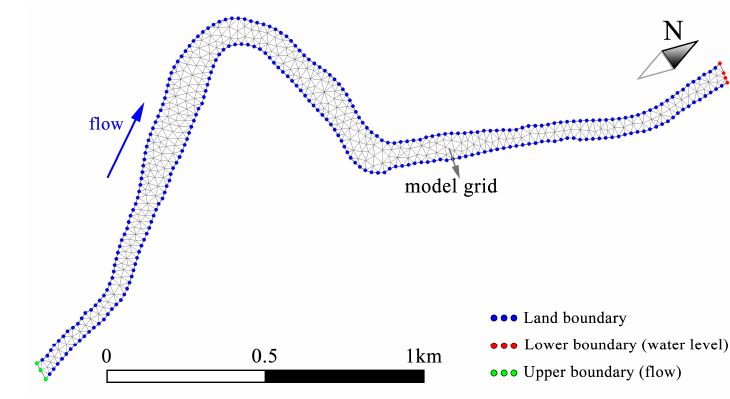
Figure 5. Habitat grid model. Water 2019 , 11 , x FOR PEER REVIEW